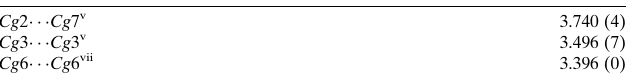
Table 3 (cid:3) – (cid:3) stacking geometry (A˚ ) for